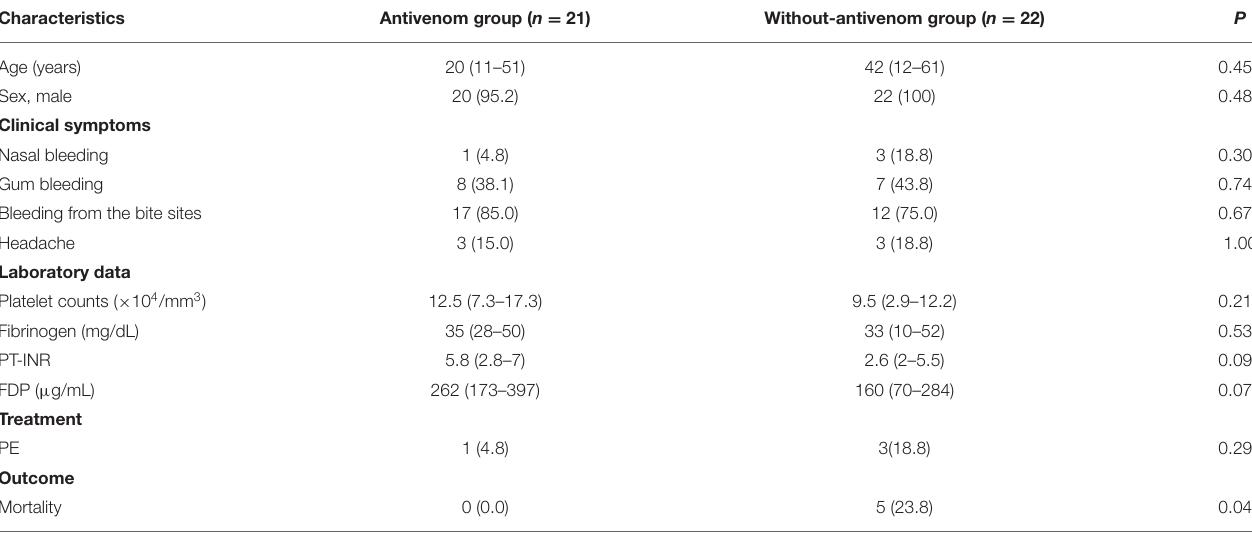
TABLE 2 | Comparison of clinical characteristics between the antivenom and without-antivenom patient groups. Characteristics